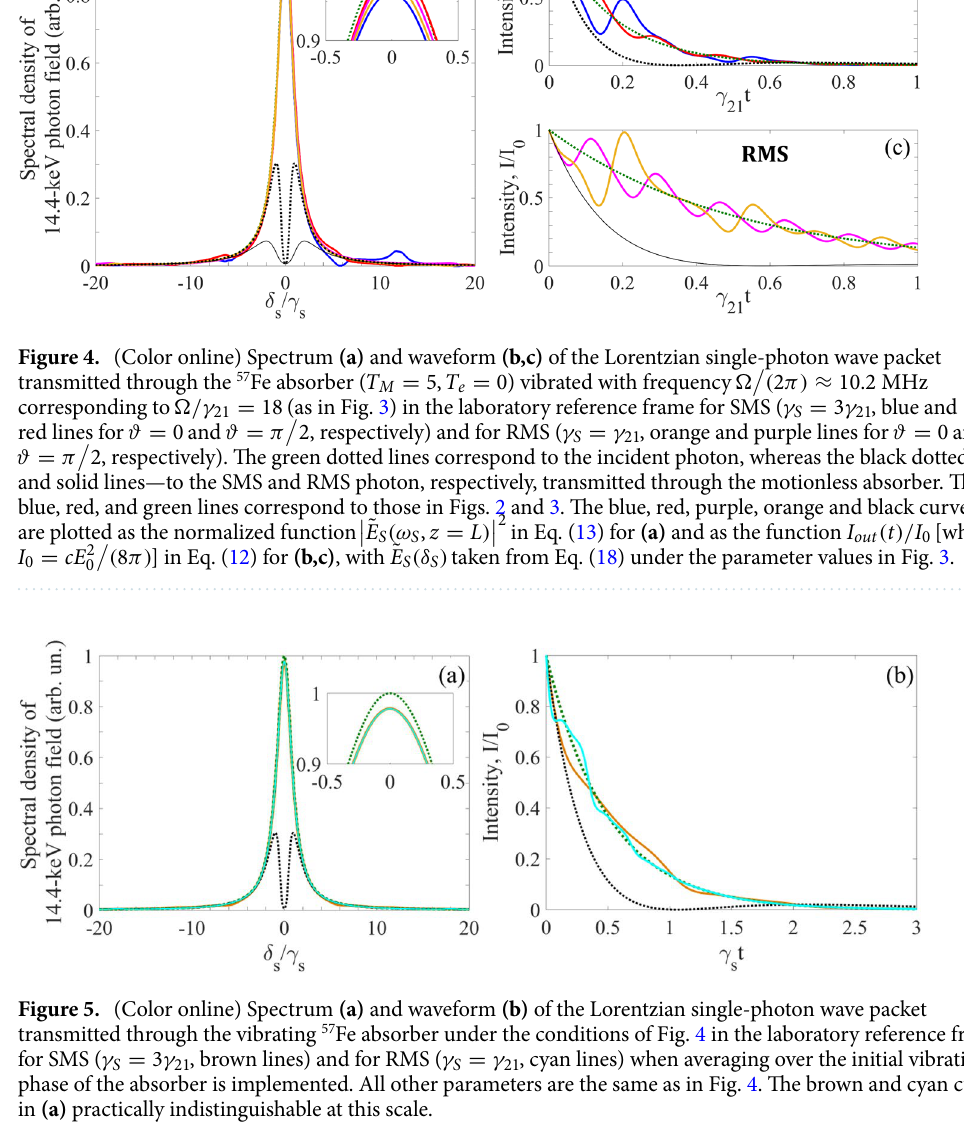
Figure 5. (Color online) Spectrum (a) and waveform (b) of the Lorentzian single-photon wave packet transmitted through the vibrating 57 Fe absorber under the conditions of Fig. 4 in the laboratory reference frame 3 γ 21 , brown lines) and for RMS ( γ for SMS ( γ S S = γ 21 , cyan lines) when averaging over the initial vibration = phase of the absorber is implemented. All other parameters are the same as in Fig. 4. The brown and cyan curves in (a) practically indistinguishable at this